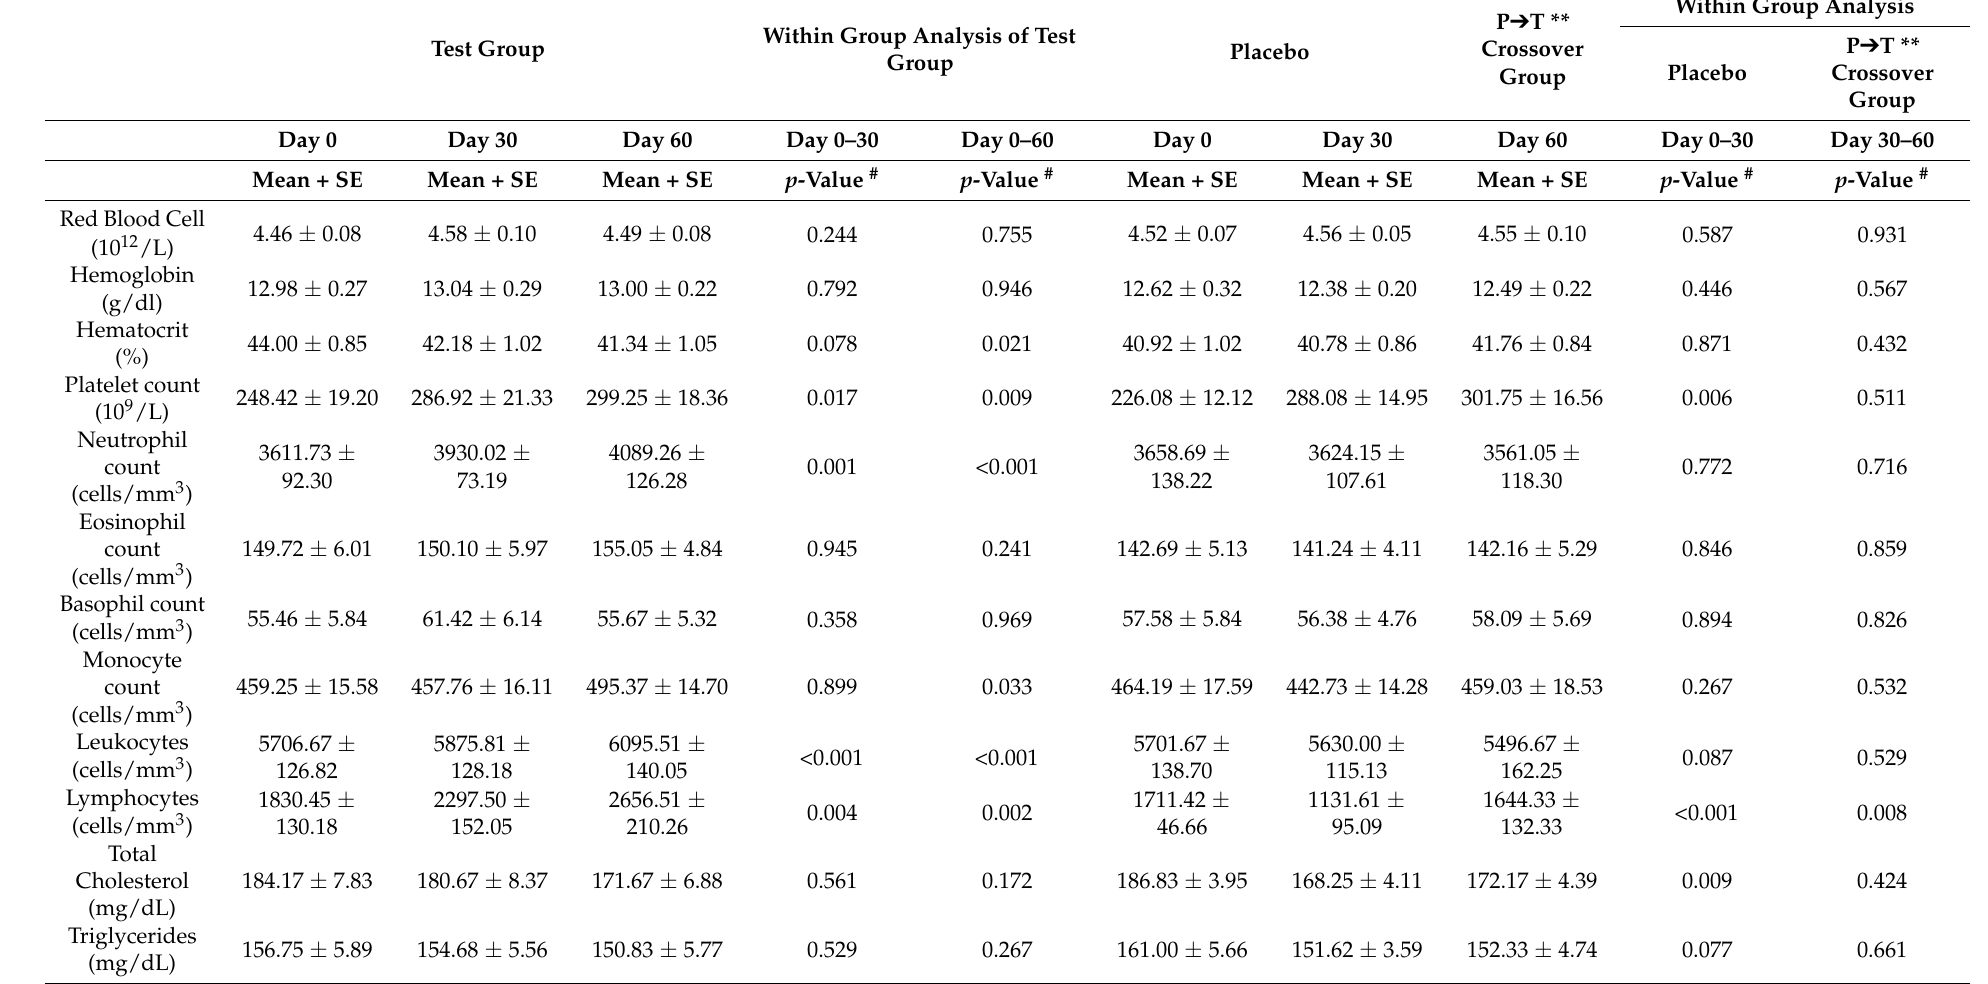
Table 4. Comparison of biochemical and safety parameters in plasma samples of test and placebo group at day 0, 30 and